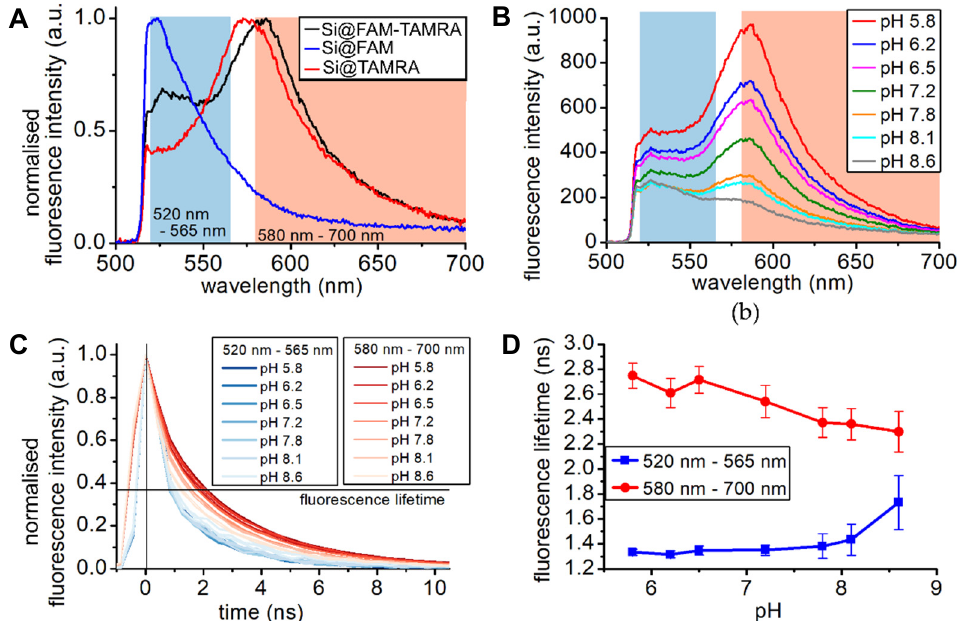
Figure 5. Response to pH of a dual fluorophore optode: ( A ) Fluorescence spectra of the dual fluorophore loaded beads, Si@FAM-TAMRA, and beads loaded only with carboxyfluorescein (Si@FAM) and tetramethylrhodamine (Si@TAMRA). The shaded area indicates the chosen carboxyfluorescein dominated spectral region (blue) and the tetramethylrhodamine dominated spectral region (red). ( B ) Spectral changes of the ratiometric sensor with pH. ( C ) Normalised fluorescence decays; the spectral histograms were summed over the range of 520 to 565 nm for the carboxyfluorescein dominated spectral region (blue) and from 580 to 700 nm for the tetramethylrhodamine spectral region (red). ( D ) Fluorescence lifetime, derived from the fluorescence decays via an exponential fitting routine.